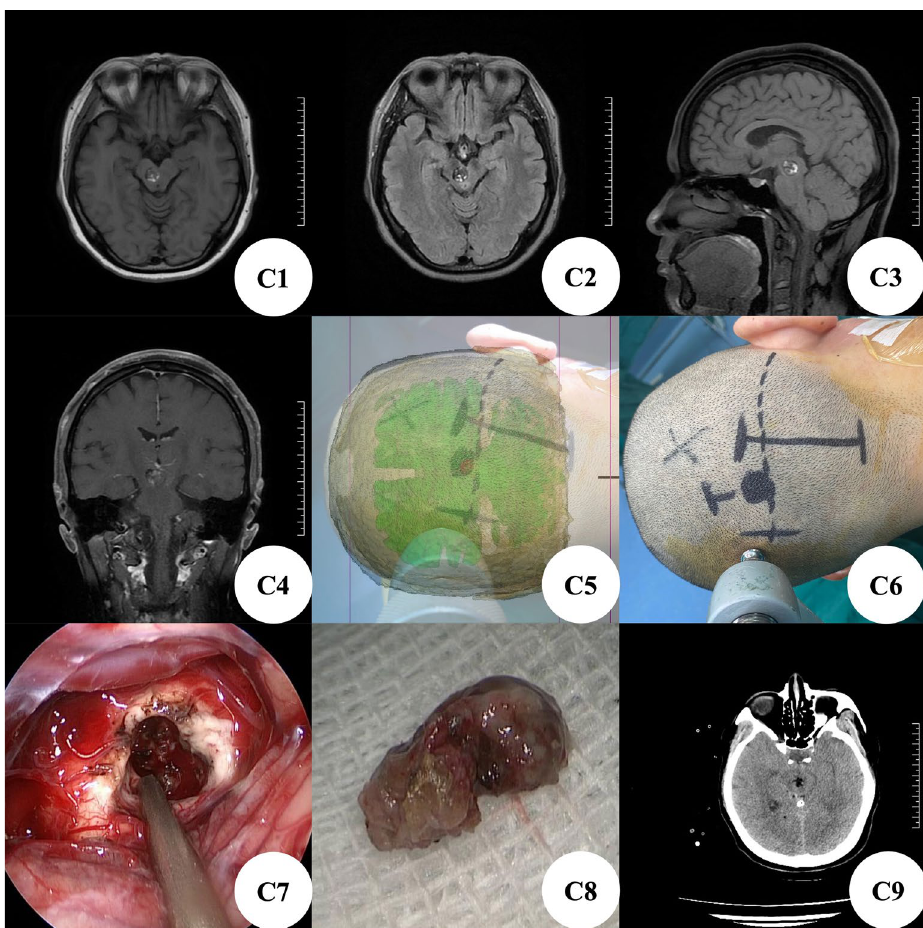
Figure 3. ( C1–C4 ) MRI examination of the brain showed space occupying lesions on the right side of the midbrain and cavernous hemangioma; ( C5 ) use the Apple mobile phone APP MosoCam to project the scalp surface of the tumor; ( C6 ) the surgical incision was designed according to the projection position; ( C7 ) cavernous hemangioma was found by neuroendoscopy during operation; ( C8 ) complete resection specimens of cavernous hemangioma; ( C9 ) postoperative brain CT showed that the cavernous hemangioma was removed completely and there was no delayed bleeding in the operation